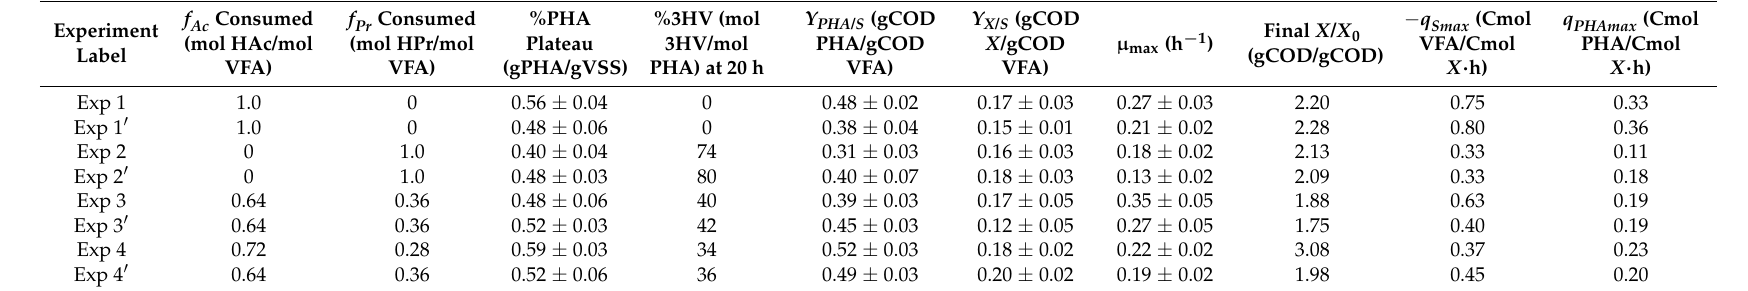
Table 2. PHA accumulation yields and kinetic